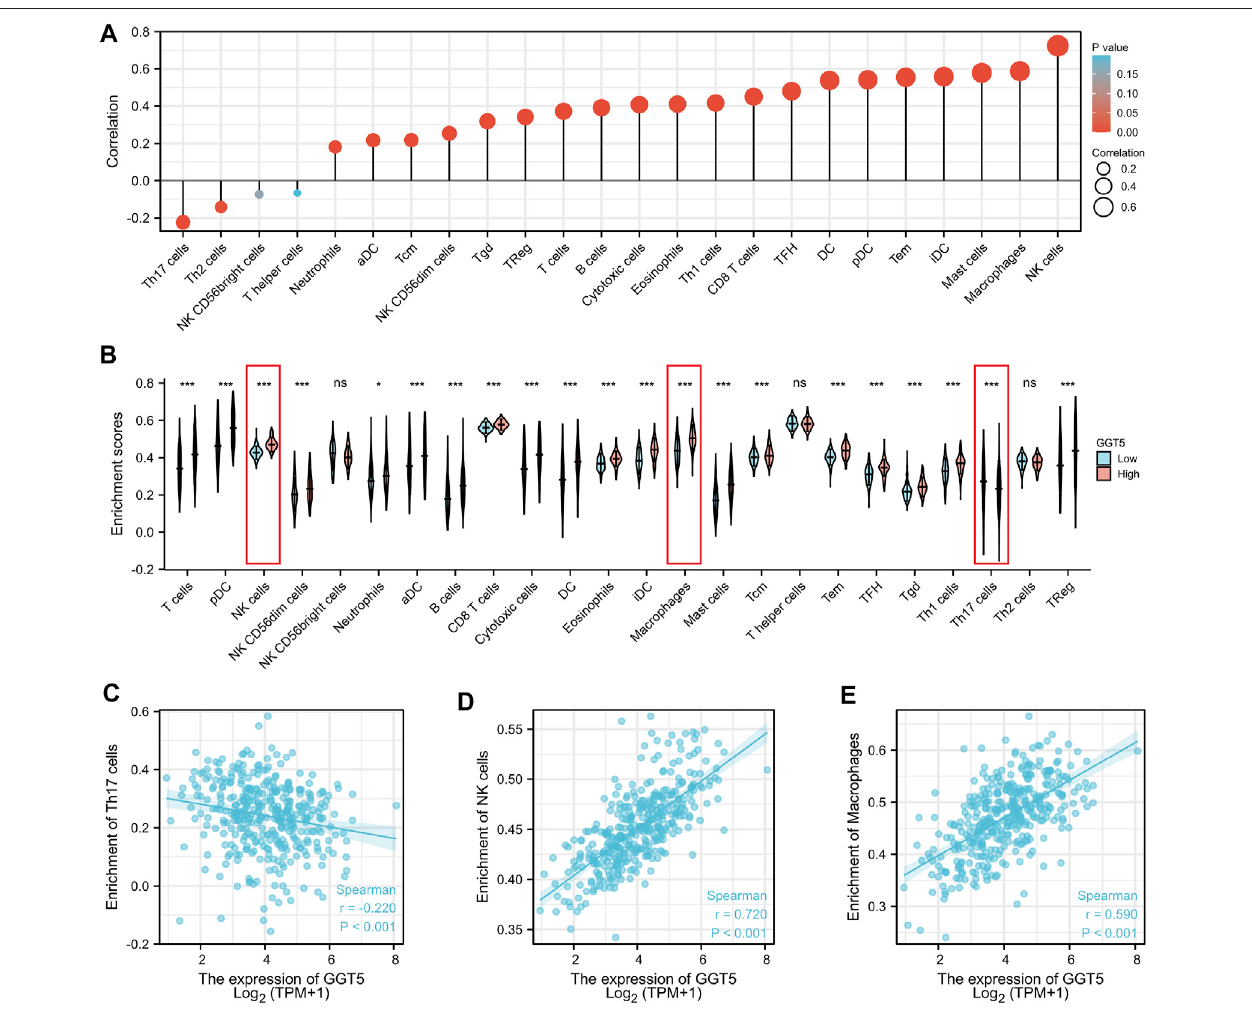
FIGURE 5 | The expression level of GGT5 was closely associated with the degree of immune cell in fi ltration in the tumor immune environment. (A) Correlation analysisbetweentheexpressionlevelof GGT5 andthedegreeofimmunecellin fi ltration. (B) Comparisonofthedifferentimmunecellsin fi ltrationlevelsunderhighandlow GGT5 expression conditions. (C – E) The scatter plots show the correlation between GGT5 expression and the in fi ltration degrees of Th17 cells, macrophages, and NK cells. *, p < 0.05; ***, p < 0.001; ns, not signi fi cant, p > 0.05.